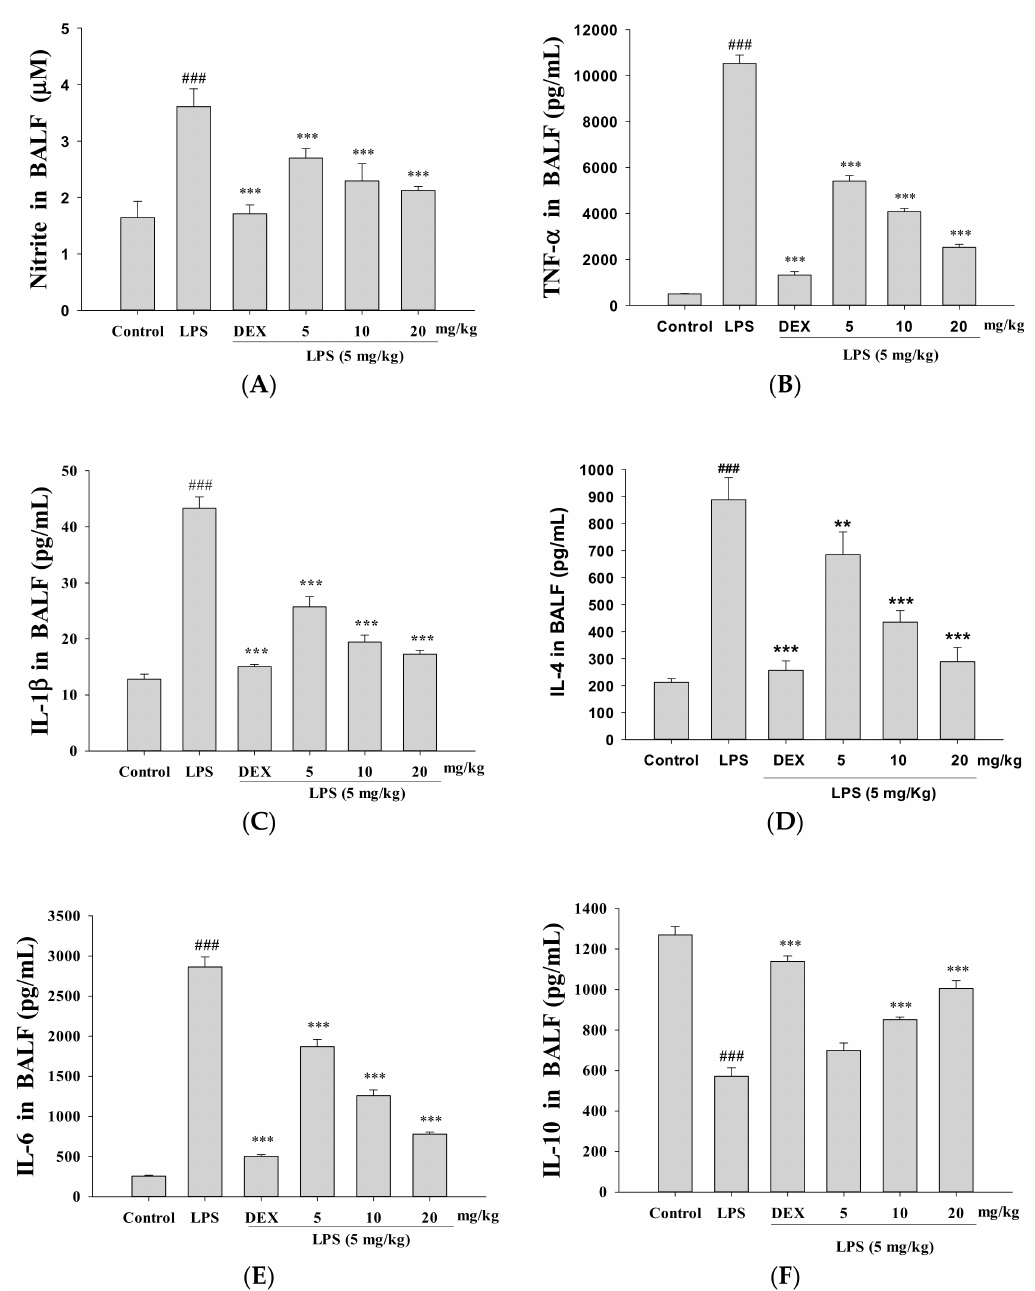
Figure 3. GRh2 downregulated ( A ) nitric oxide (NO); ( B ) tumor necrosis factor-alpha (TNF- α ); ( C ) IL-1 β ; ( D ) IL-4; and ( E ) IL-6; and ( F ) increased IL-10 in BALF. BALF was collected. NO, TNF- α , IL-1 β , IL-4, IL-6, and IL-10 were detected at 6 h after LPS challenge by enzyme-linked immunosorbent assay (ELISA). Data are represented as mean ± S.E.M. ( n = 5). ### denotes p < 0.001 compared with sample of control group. ** p < 0.01 and *** p < 0.001 compared with LPS-only